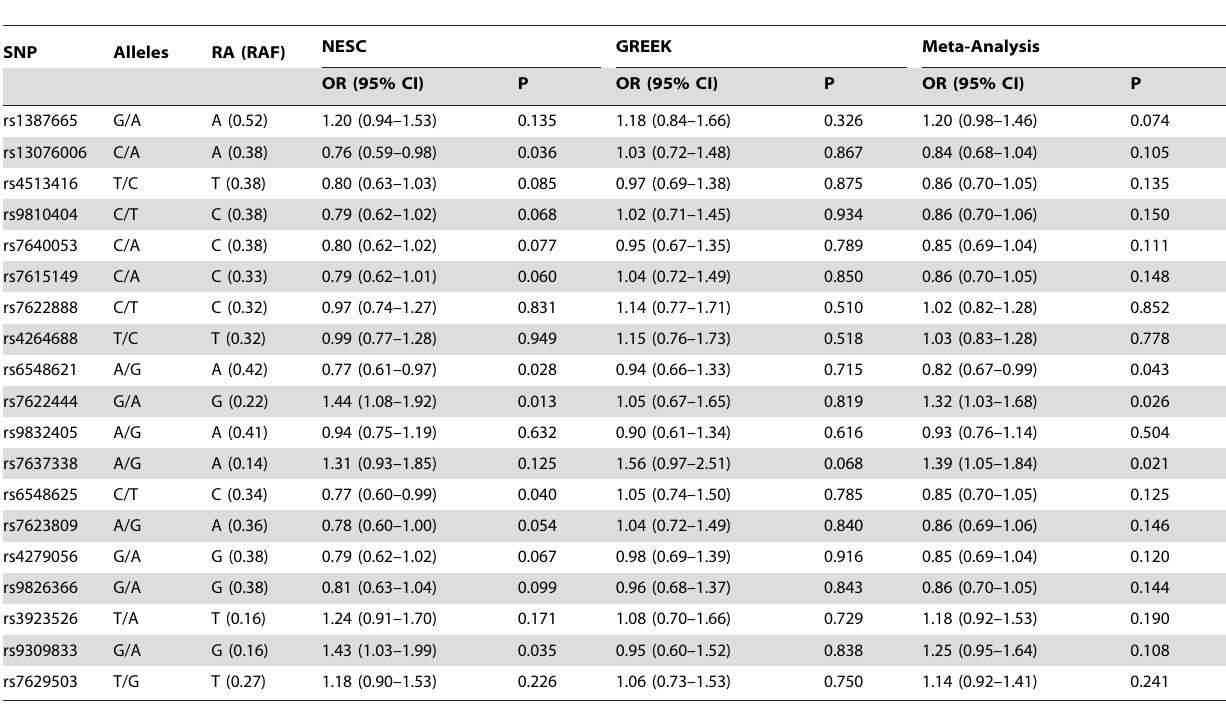
Table 2. Association results of ROBO1 SNPs for wet AMD in the NESC and GREEK cohorts, and in meta-analysis using an additive